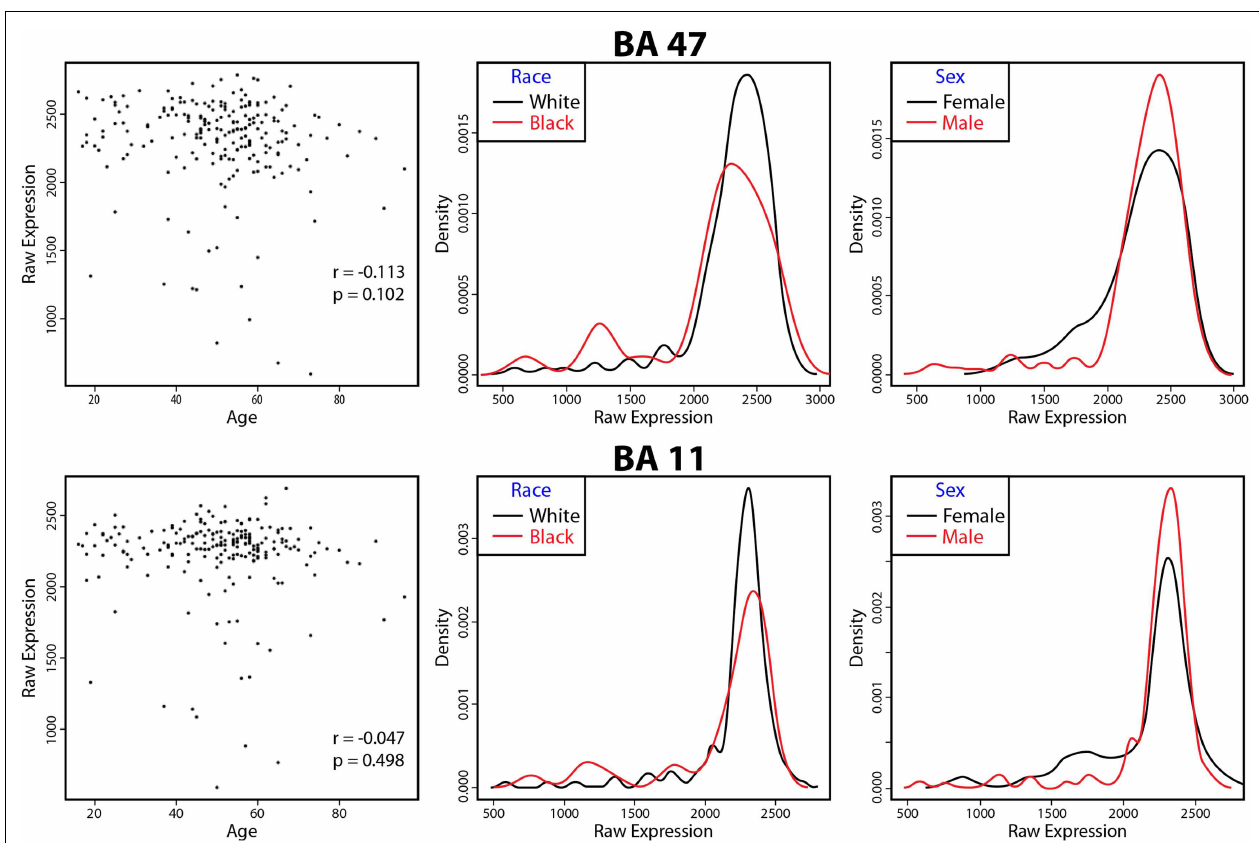
FIGURE 1 |VSNL1 expression as a function of age, race, and sex .The correlation ofVSNL1 expression levels with age are shown in the first panels for each area.The second and third panels show the density of expression levels as a function of race and sex. No associations were significant. BA, Brodmann area.